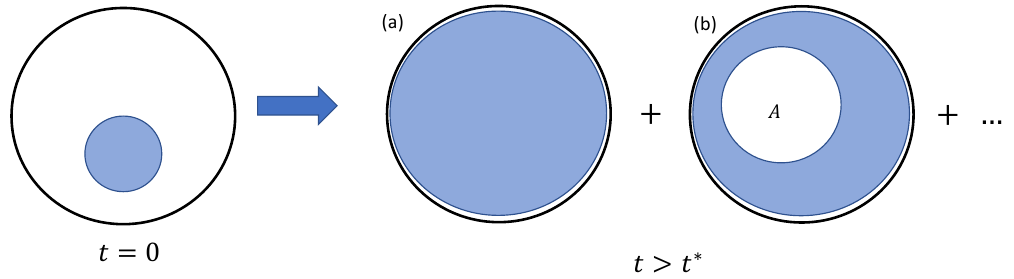
Figure 2 . Universal features of operator growth in a chaotic system. The region within the black circle represents the space of degrees of freedom, and shaded regions indicate the subsystems where the operators are supported. A given initial operator evolves to a superposition of different final operators. After some time t greater than the scrambling time t ∗ , a typical process is one where the operator becomes supported on the entire space, as shown in term (a). For any subsystem A , there is a small probability that the final operator is equal to the identity in A , as shown in the term (b). We refer to the presence of terms like (b) as void formation in A